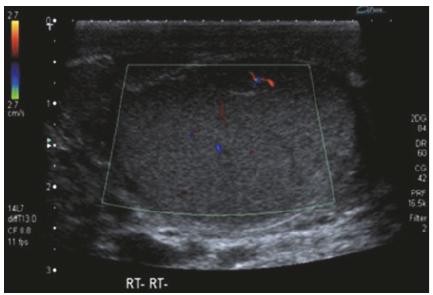
Figure 4: Follow-up ultrasound scan of right testis with normal